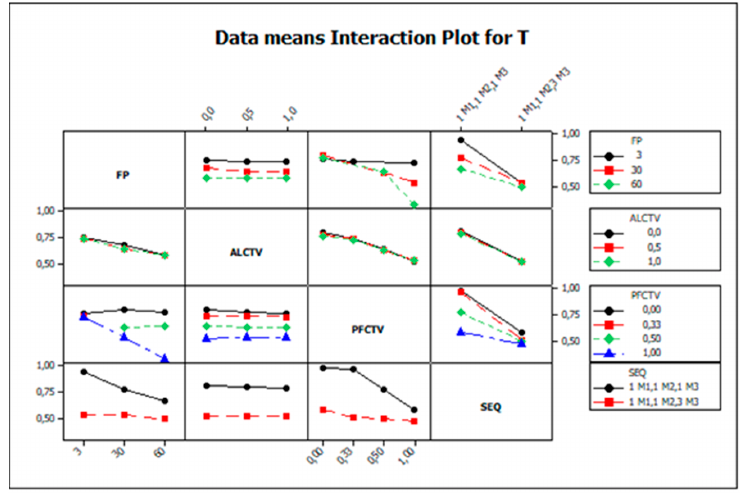
Figure 6. Interaction plot of the input parameters FP, ALCTV, PFCTV, SEQ for T. Appl. Sci. 2023 , 13 , x FOR PEER REVIEW